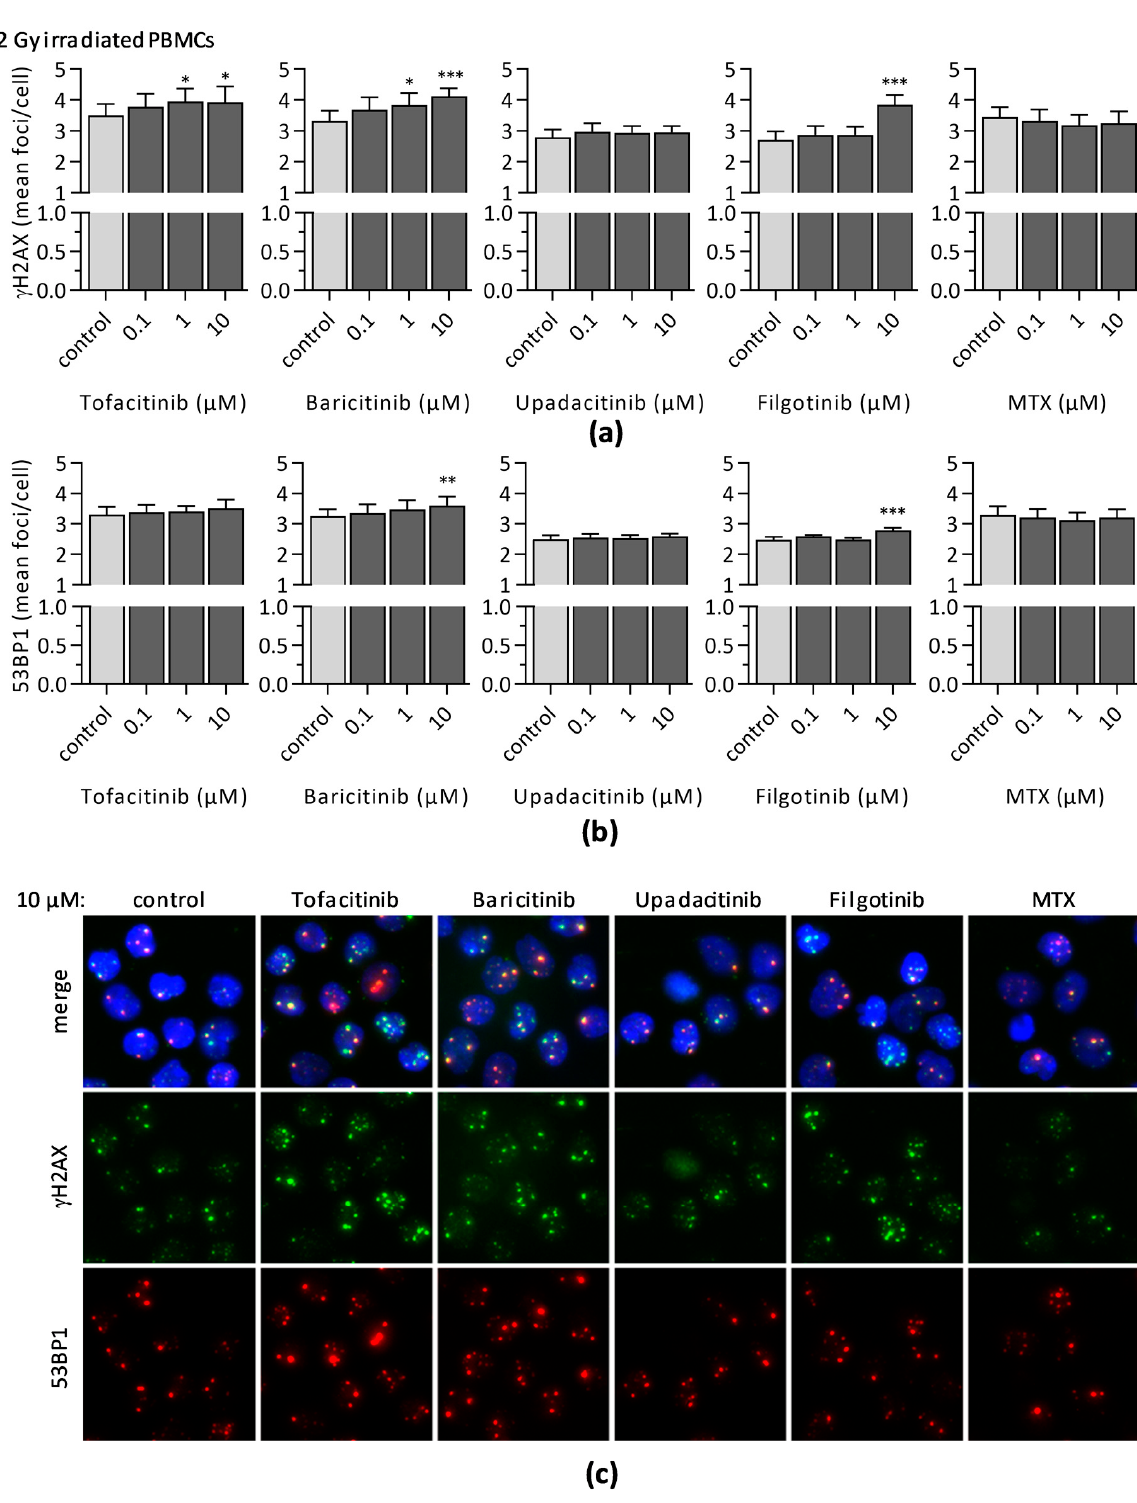
Figure 6. The mean number of residual ( a ) γ H2AX and ( b ) 53BP1 foci per cell were assessed 24 h after 2 Gy irradiation of unstimulated PBMCs in the presence of indicated JAKi or MTX to analyze DNA repair by means for foci clearance. Diagrams display the mean ± SEM of seven independent experiments (*** p ≤ 0.001; ** p ≤ 0.01; * p ≤ 0.05). ( c ) Representative immunofluorescence microscopy images of PBMCs from one donor treated with either 10 µ M JAKi or MTX. Colors indicate DNA/DAPI (blue), γ H2AX (green), and 53BP1 (red).